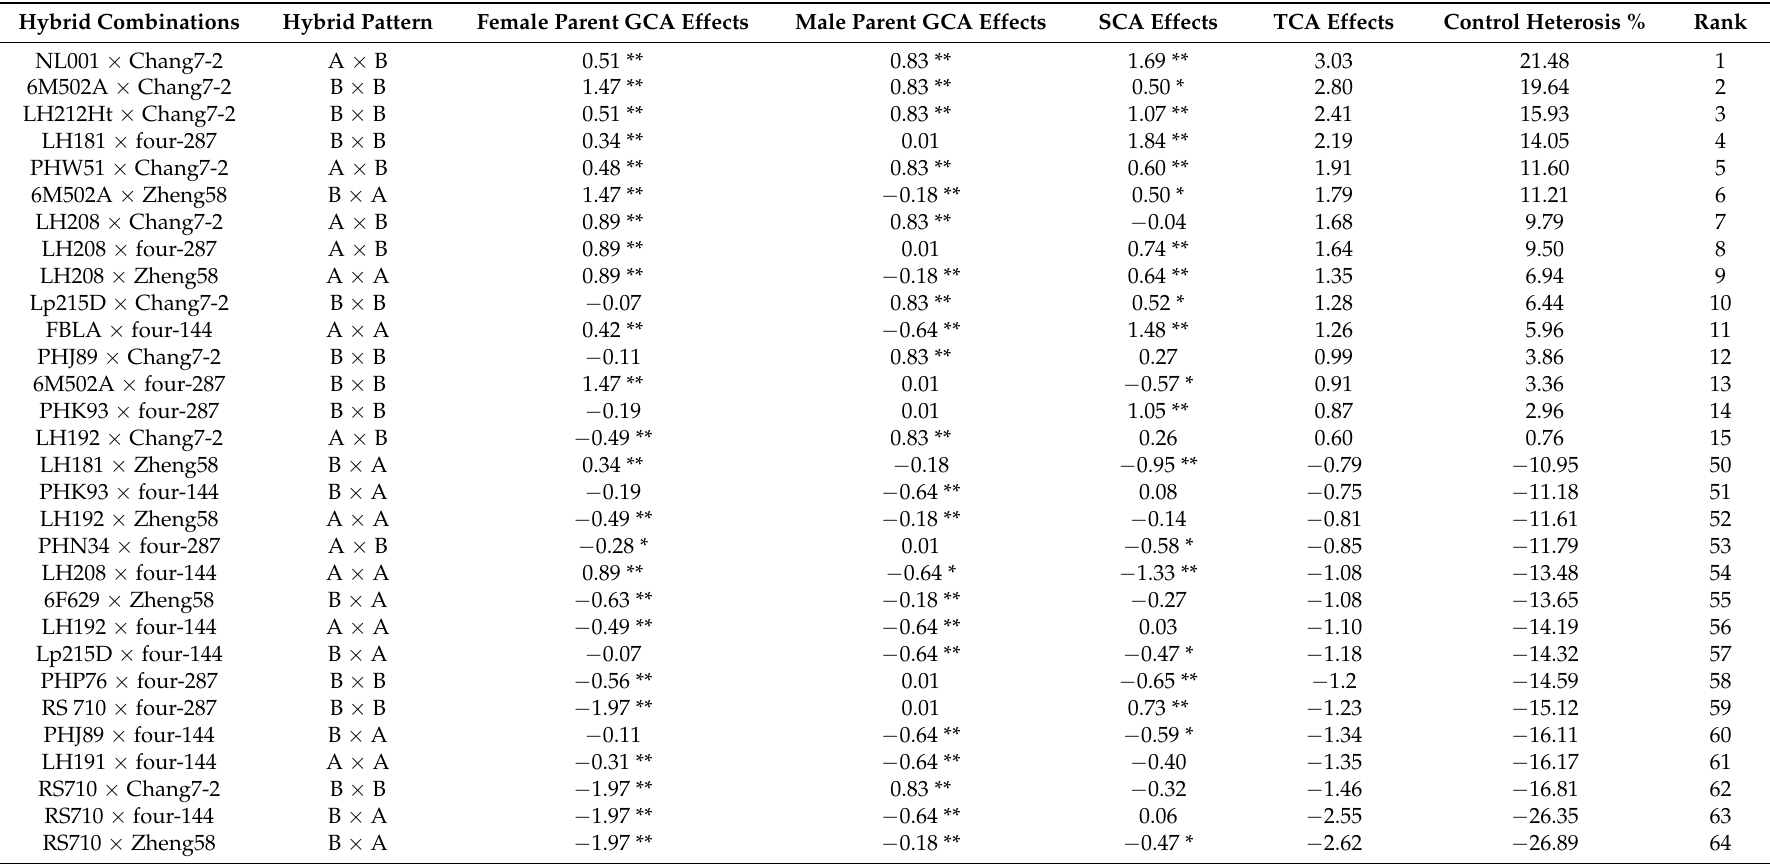
Table 13. Ranking of hybrids according to their total combining ability and control